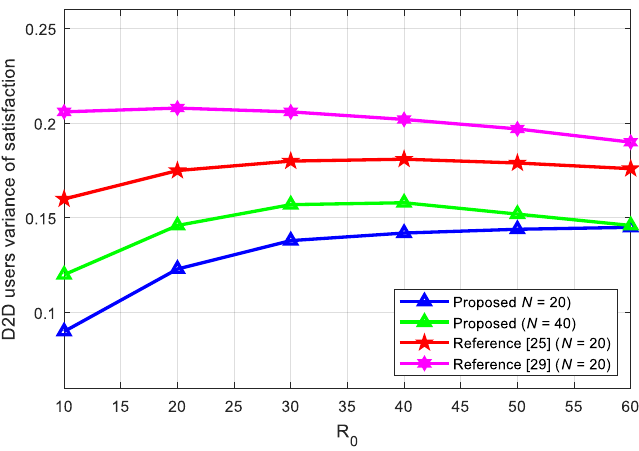
Figure 9. Comparison of the variance of user satisfaction of D2D users under different number of D2D R 0 𝑅 0 .